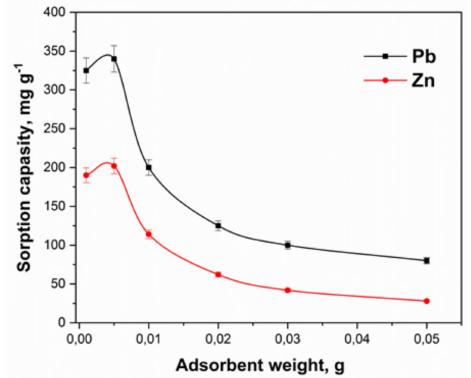
Figure 8. The influence of sorbent weight on sorption of lead and zinc ions in acetic-acetate buffer systems.